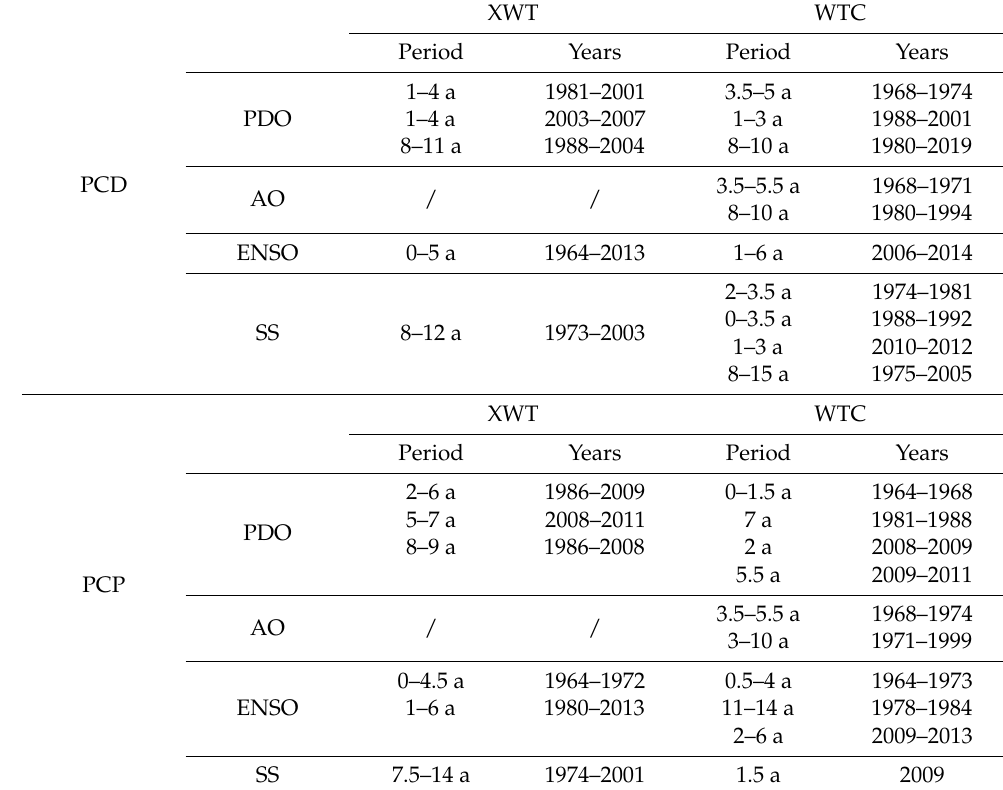
Table 1. Period and occurrence years of CWT analysis between PCD/PCP and